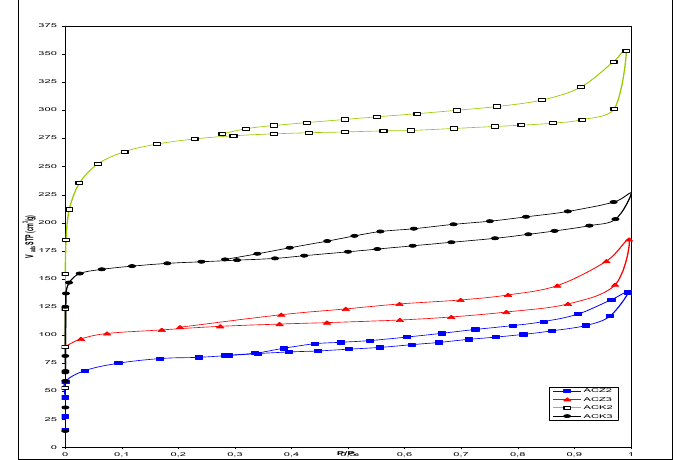
Figure 2. Nitrogen adsorption-desorption at 77 K for activated carbon